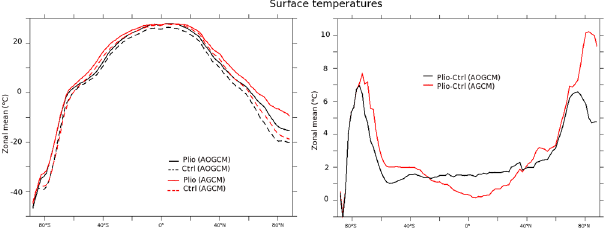
Fig. 7. Zonal mean surface temperature for the mid-Pliocene ex- periments and the control (left), and zonal mean surface tempera- ture anomaly to the control for both Pliocene experiments (right), expressed in degrees